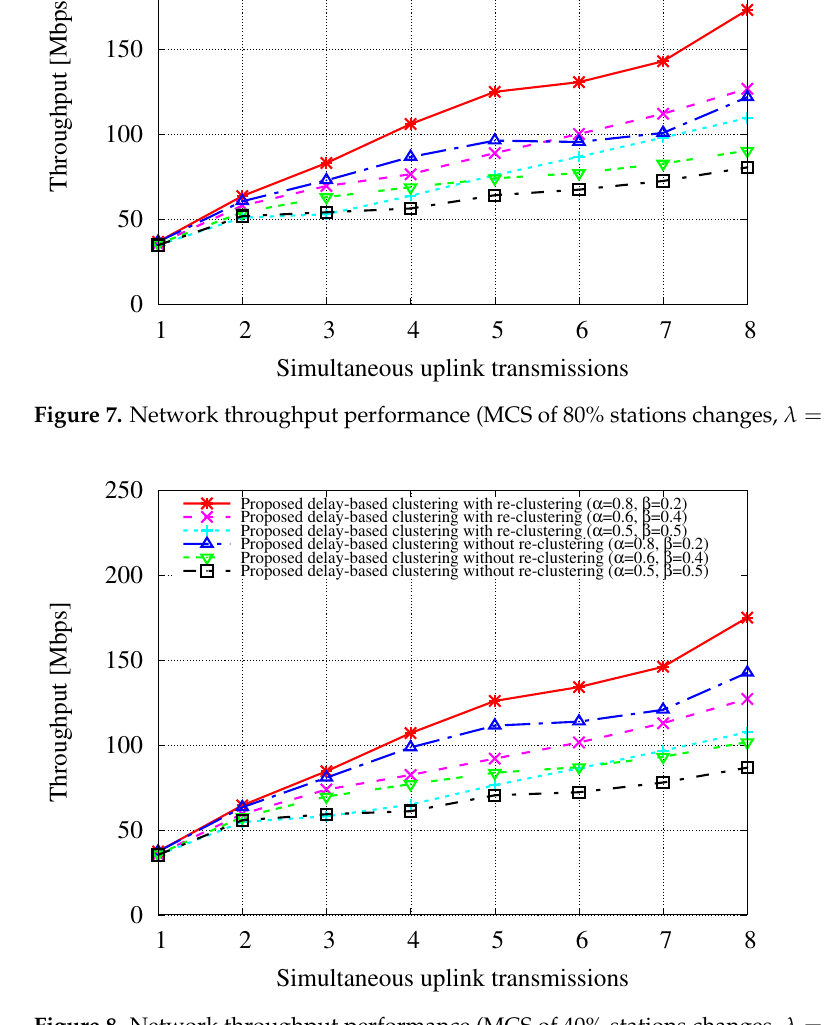
Figure 8. Network throughput performance (MCS of 40% stations changes, λ =